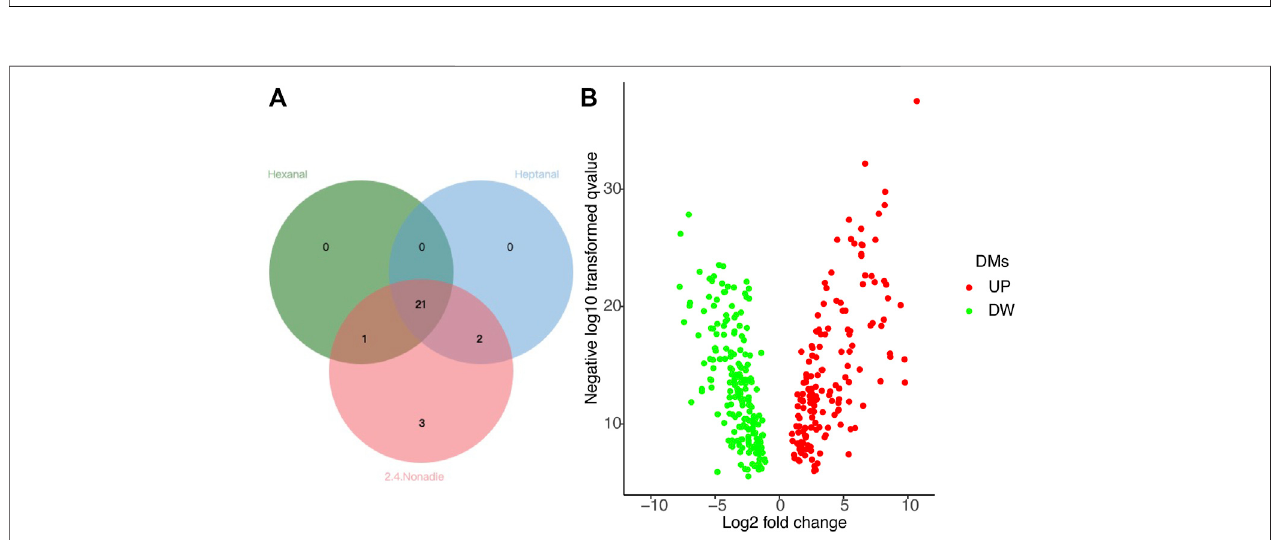
FIGURE 5 | (A) Common DMs related to hexanal, heptanal, and (E,E)-2, 4-nonadienal, in the blue module of the BM tissue network. (B) Volcano plot of differential metabolites (DMs).